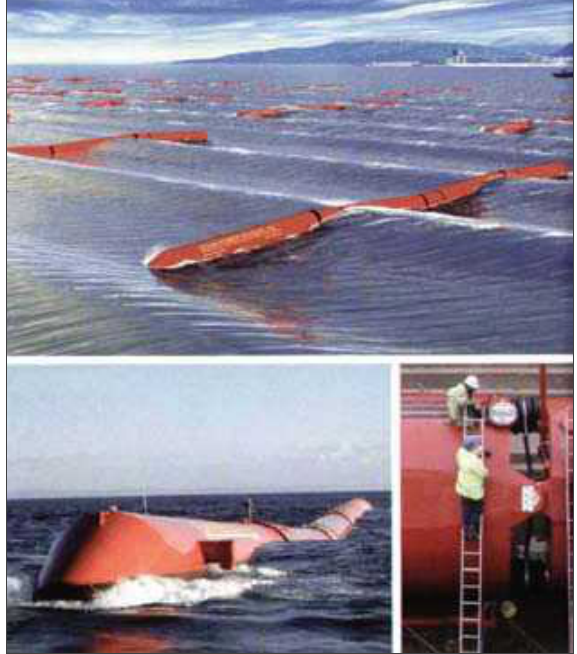
Fig. 4. Inpacts of wavepowerstations for quality of sea